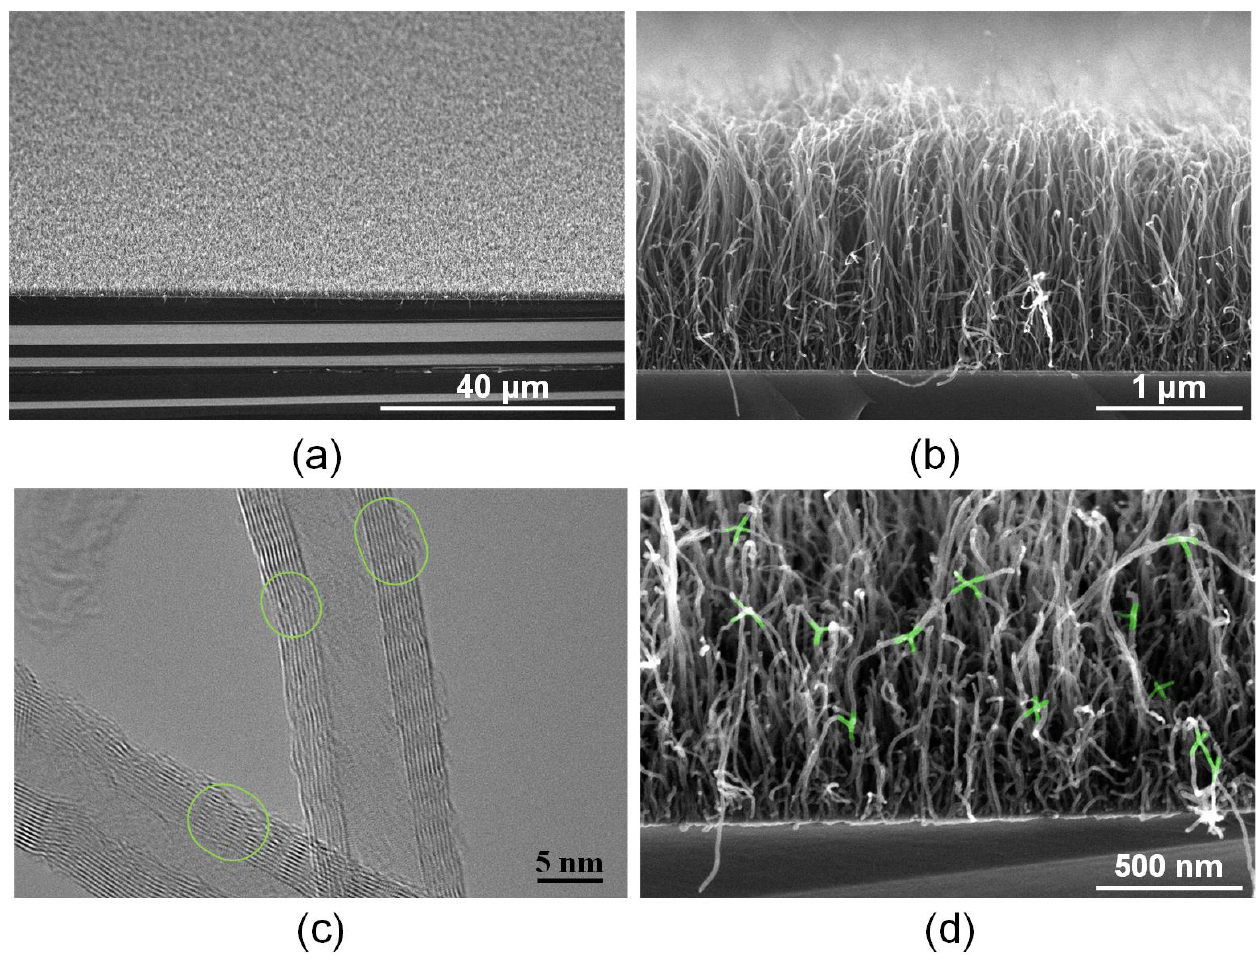
Figure 3. SEM ( a , b ) and TEM ( c ) images of MWCNT arrays on Si substrate before and after laser exposure with an energy density of 0.013 J/cm 2 ( d ). Green ovals show transition regions in which there is a higher number of defects in the area compared to that in the defect-free part of the nanotube framework. Nanotube binding regions are highlighted in green.